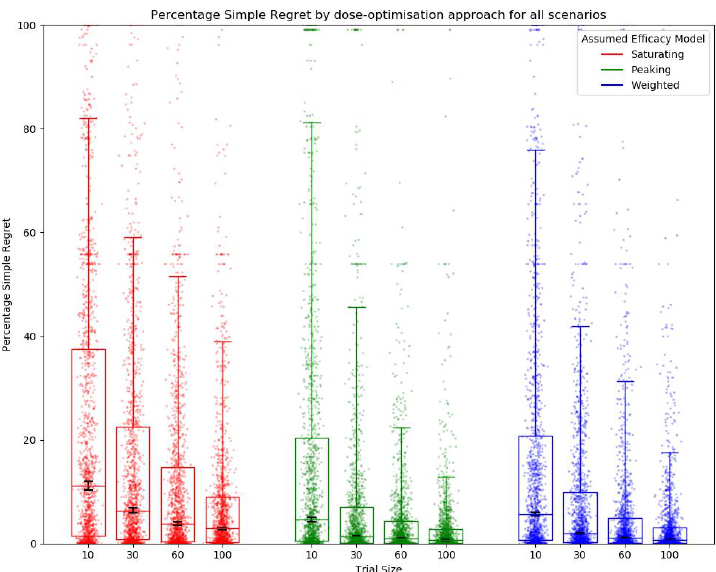
Figure 7. Percentage simple regret (PSR) for all scenarios by assumed efficacy model and trial size. Trial dose selection method was full uniform exploration. A lower PSR denotes a more optimal final dose. Individual points represent PSR for a single simulated clinical trial using one dose-optimisation approach for one of the 14 scenarios. The middle line of each boxplot is the median value; the box marks the 25th and 75th percentiles, and the whiskers mark the 5th and 95th percentiles of the data. Black lines represent the 95% confidence interval for the median of each distribution [47]. The majority of these distributions of PSR were different to a statistically significant extent at the p = 0.05 threshold according to the Kolmogorov – Smirnov test due to the large number of simulations con- ducted (100 per approach/scenario pairing). For further details on statistical significance see Sup- plementary S12. Similarly, the accuracy of the predicted utility at the predicted optimal dose increased with increasing trial size (decreased inaccuracy) (Figure 8) . An ‘optimistic bias’ was ob- served (positive inaccuracy) (Figure 8a), with predicted utility typically higher than the true utility for the given dose, as is often expected in optimisation problems [48,49] (Sup- plementary S9). There was no difference in inaccuracy between efficacy models for any trial size.